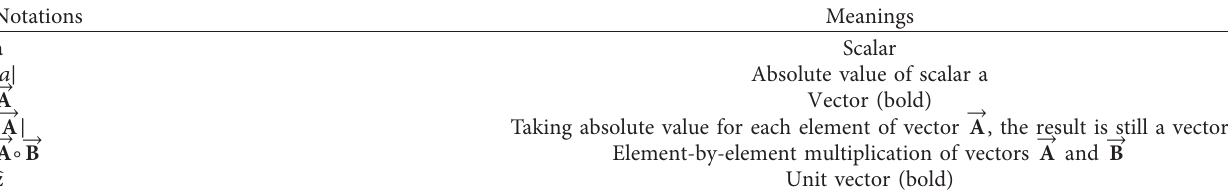
Table 1: Meanings of notations.